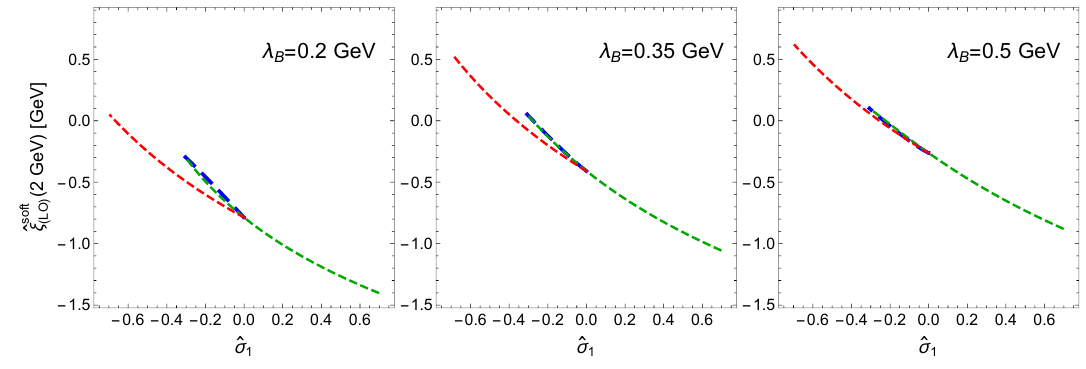
Figure 4 . The leading-order soft correction normalized to the corresponding QCD result, (2 GeV) (5.11), as a function of the (cid:12)rst logarithmic moment b (cid:24) soft ( LO )